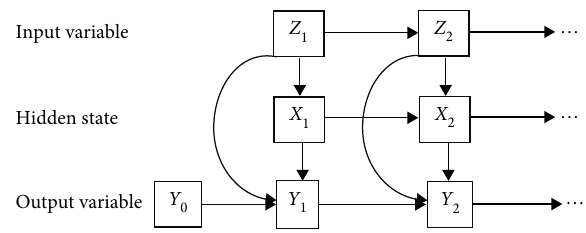
Figure 3: Bayesian network representation of our particular TMM. Figure 4: Bayesian network representation of TMM for consumer